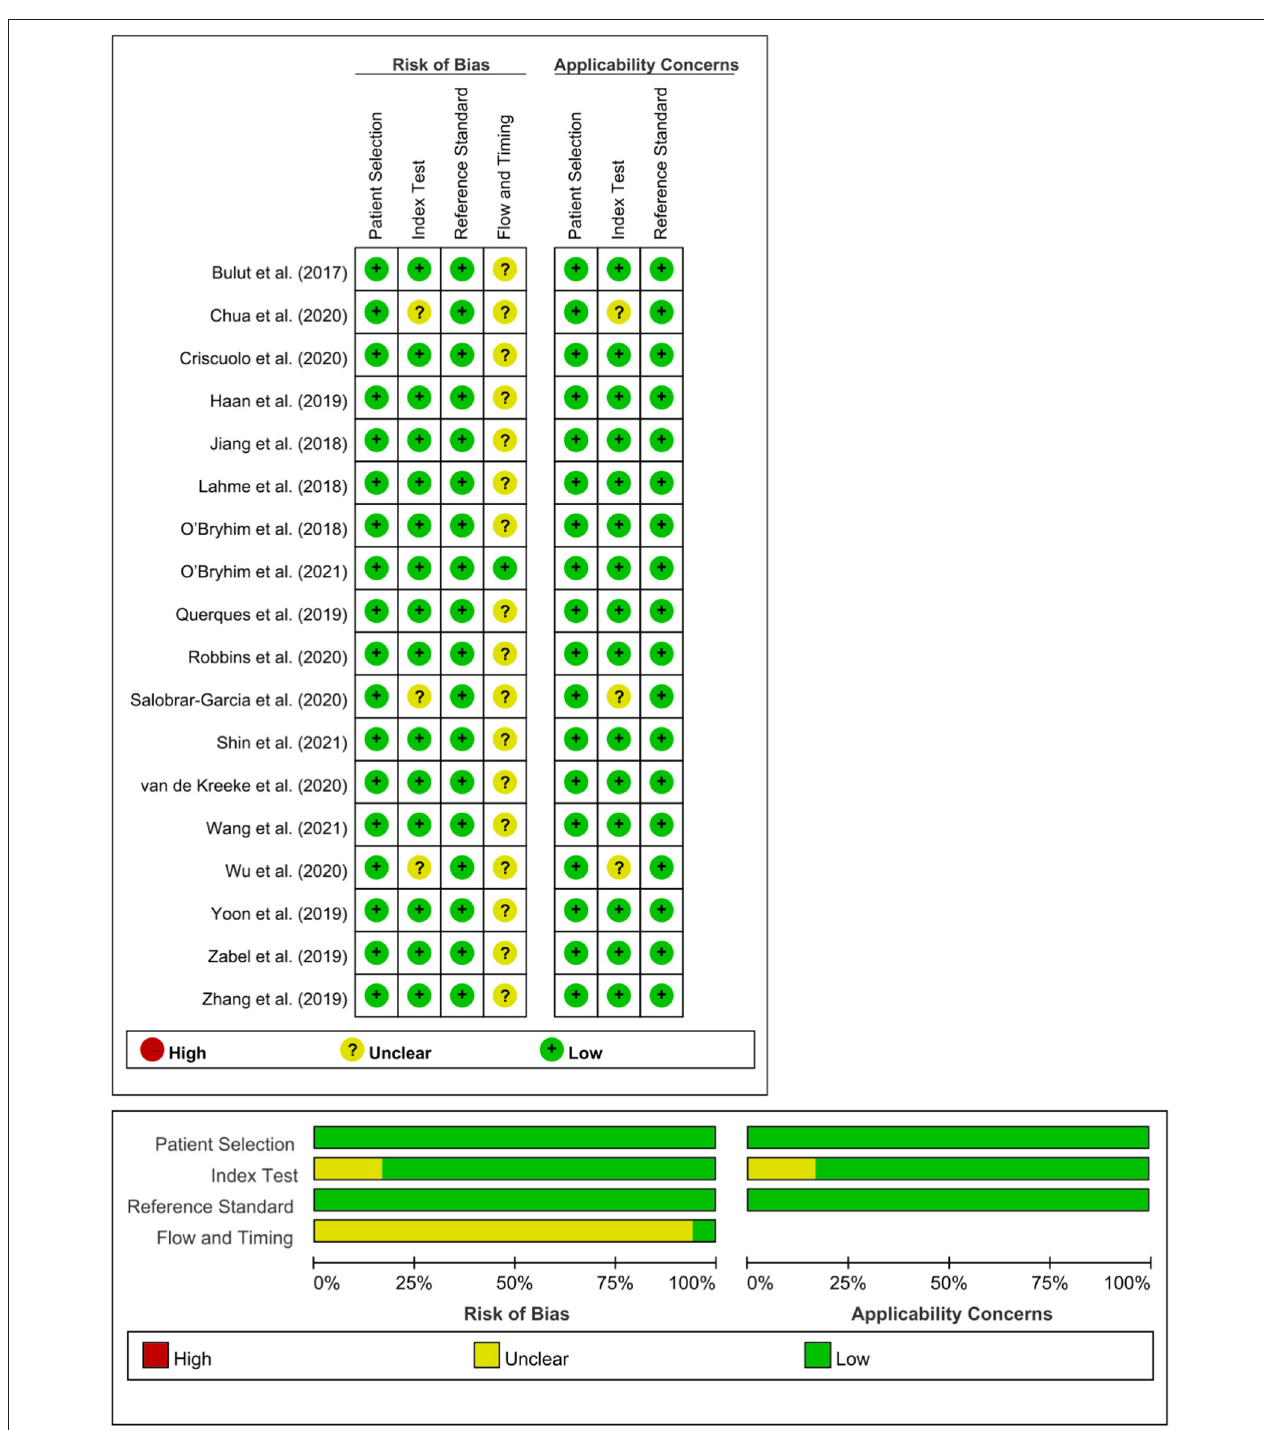
FIGURE 2 | Risk of bias summary using the QUADAS-2 assessment. We assessed study quality using the QUADAS-2, which evaluates risk of bias and applicability issues in patient selection, index test, reference standard, and flow and timing. for AD or MCI risk and OCTA measurements,